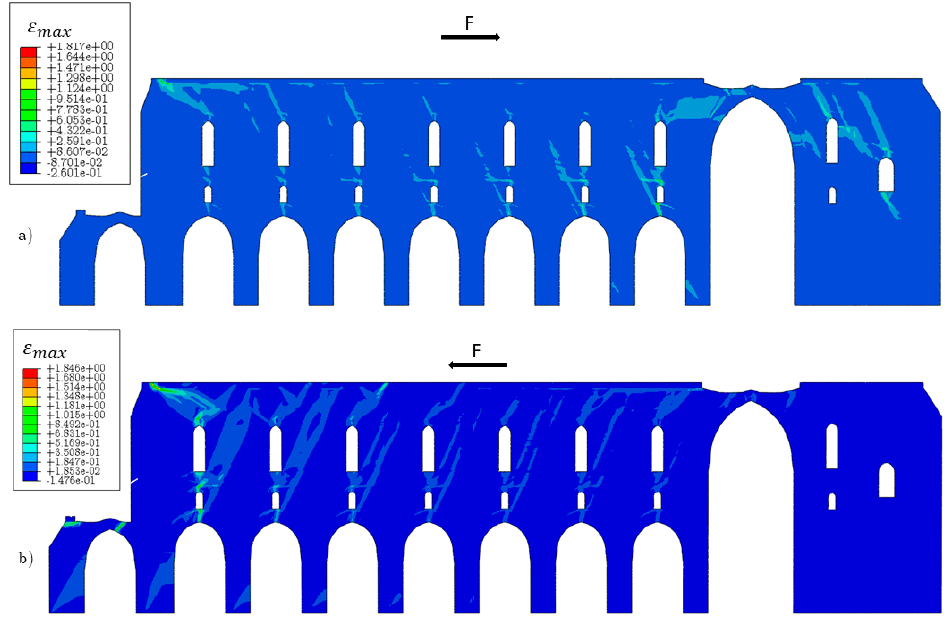
Figure 14. L macro-element: distribution of the maximum plastic strains for ( a ) positive direction of the load and ( b ) negative direction of the